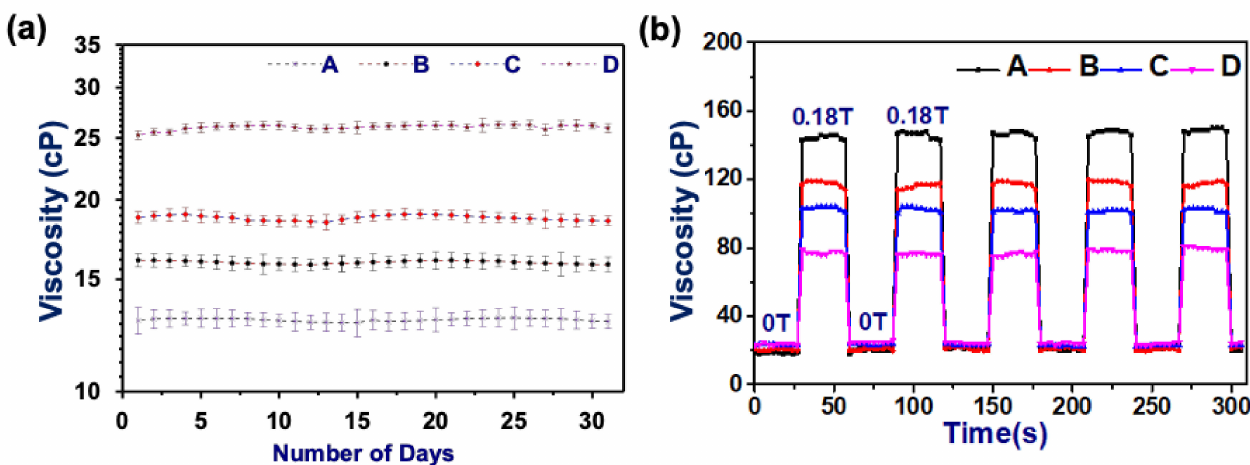
Figure 2. ( a ) Viscosity of AMF samples in the absence of magnetic field for 30 days measured by calculating the viscosity each day (average of ten measurements). The flat curve demonstrates the stability against gravity. ( b ) Viscosity vs. time response of all the samples with magnetic field ON (0.18T)/OFF(0T) consecutively for five cycles. The viscosity response to the applied gradient field shows that the viscosity almost regains the same values, which highlights the stability of the